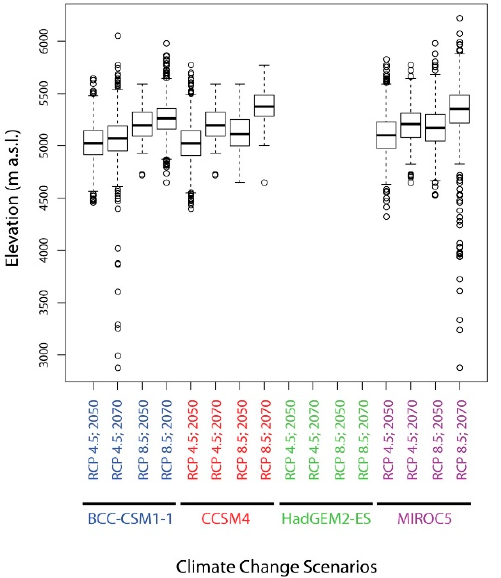
Figure 12. Elevational range of the grid cells where D. hatagirea was predicted as present (habitat suitability values ≥ 0.335) under the different climate change scenarios.